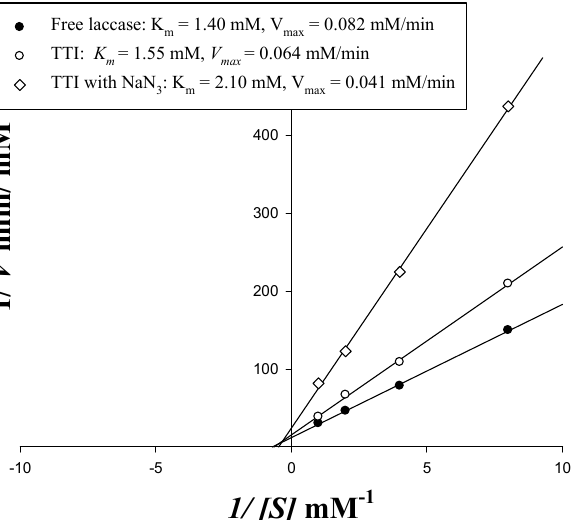
Figure 5. Kinetic parameters of free laccase and a TTI prototype with 20 µ g/cm 2 immobilized laccase (with and without 0.10 mM N-HGG).